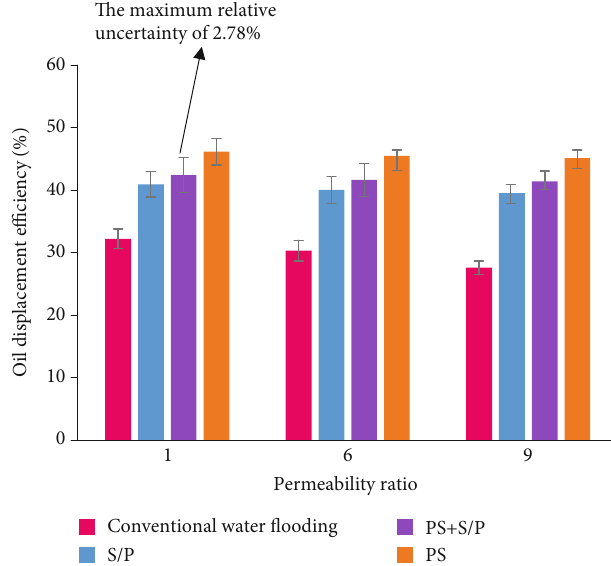
Figure 7: Oil displacement e ffi ciency after di ff erent oil displacement